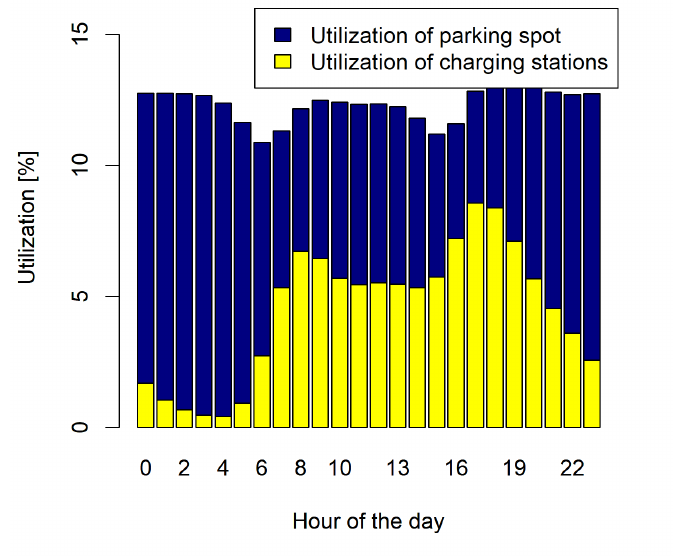
Figure 8. Comparison of hourly charging station and parking spot utilization, taken from